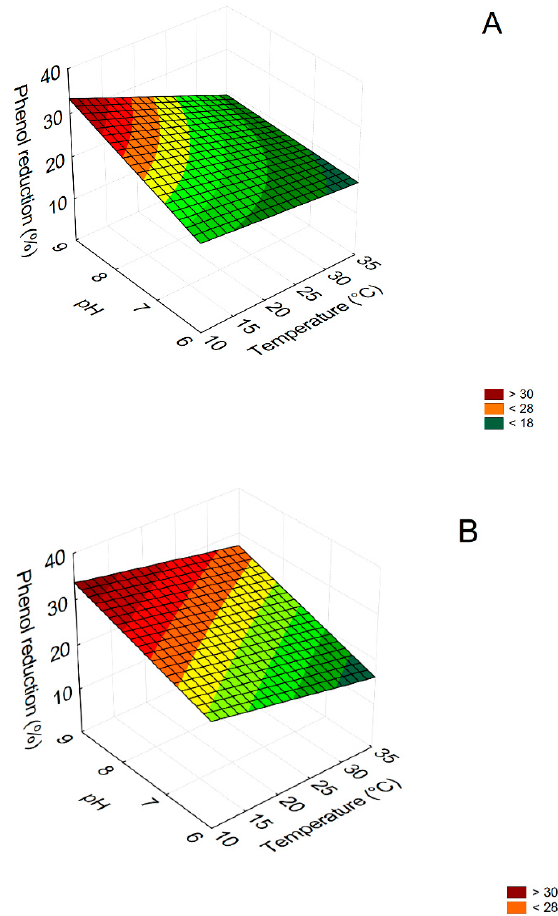
Figure 3. 3D plots for the interaction pH/temperature on phenol reduction (test 1: inoculum of C. boidinii followed 3 days after by B. pumilus ) in ATOPW (aged table olive processing water) after 3 ( A ) and 8 days after ( B ). Test A and B of Table 3.